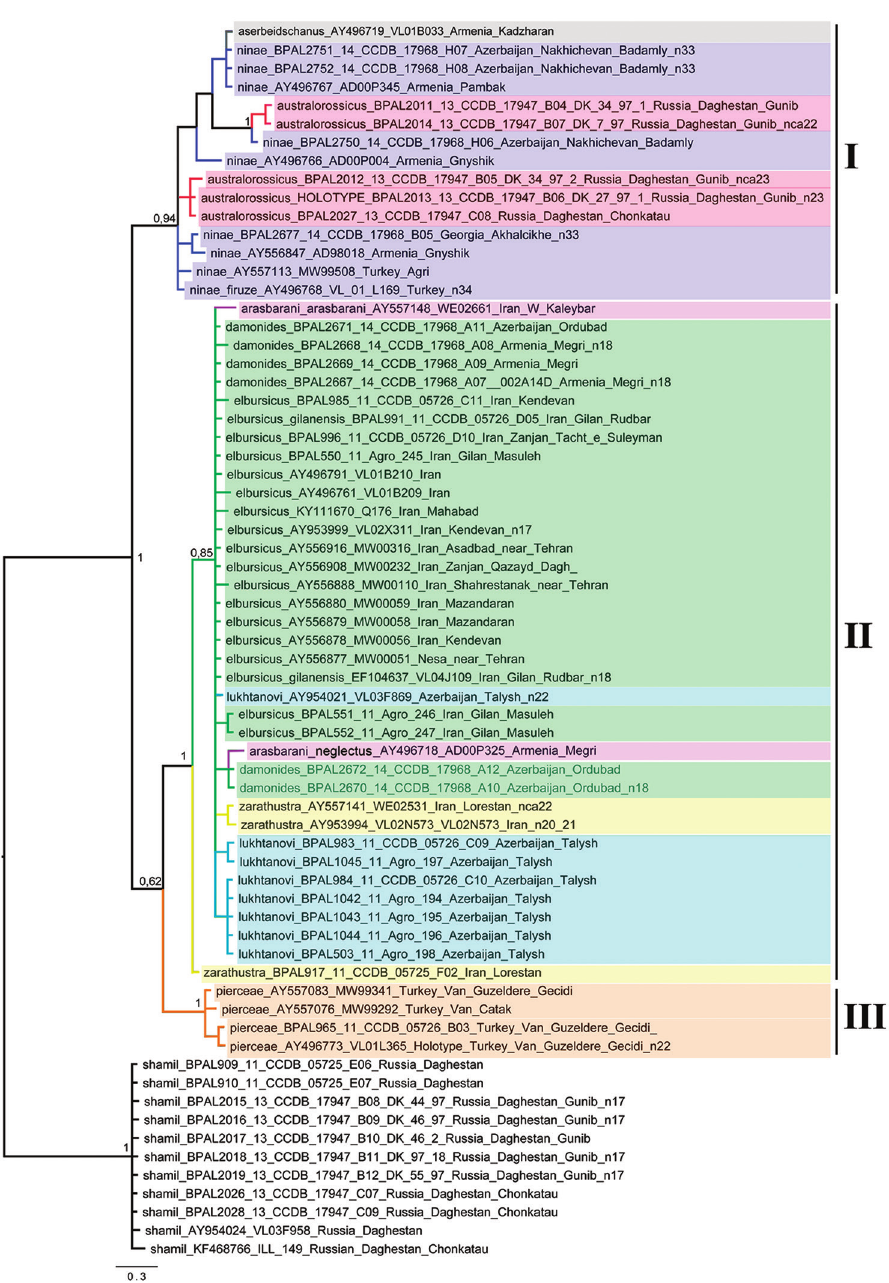
Figure 1. The Bayesian tree of studied Polyommatus samples based on analysis of the cytochrome oxidase subunit I ( COI ) gene. Numbers at nodes indicate Bayesian posterior probability. I, II and III are recovered haplogroups of the P. damonides species complex. Polyommatus shamil , phenotypically similar to P. austral- orossicus , but genetically distant, was used to root the